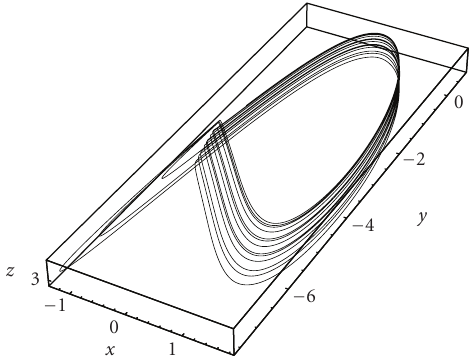
Figure 2.15. Solution visualized as a trajectory in the three-dimensional space ( I = 3 . 25, r = 0 . 005, and s = 4 . 0).